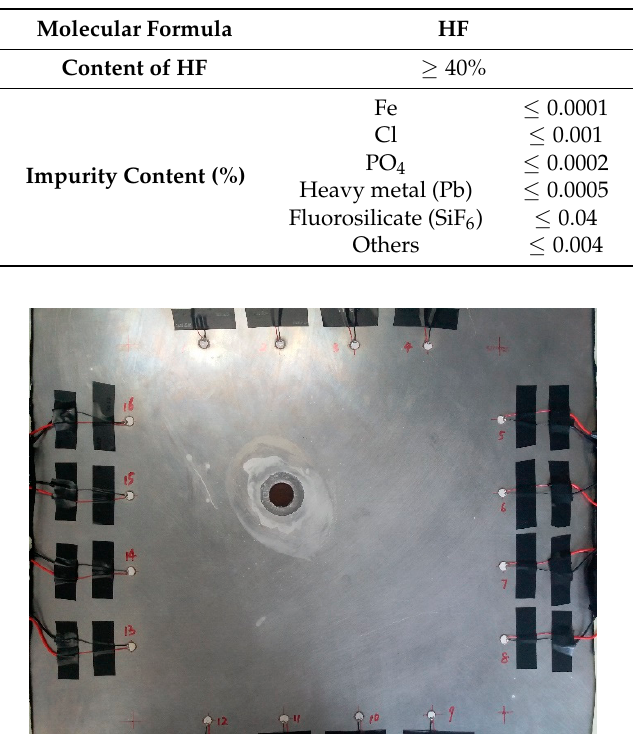
Table 2. The detailed information of hydrofluoric acid.